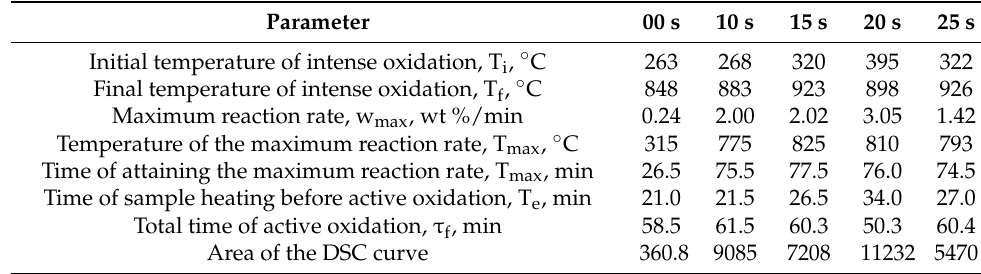
Table 1. Parameters of the test sample oxidation.